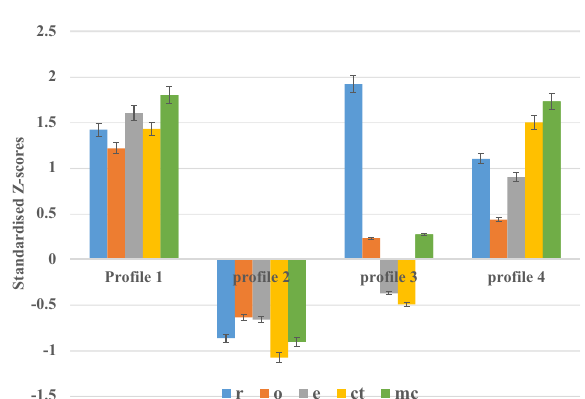
Fig. 1 A graph showing z -scores for the different cognitive and metacognitive learning skills used in the four pro fi les. r, rehearsal; o, organization; e, elaboration; ct, critical thinking; mc, metacognitive